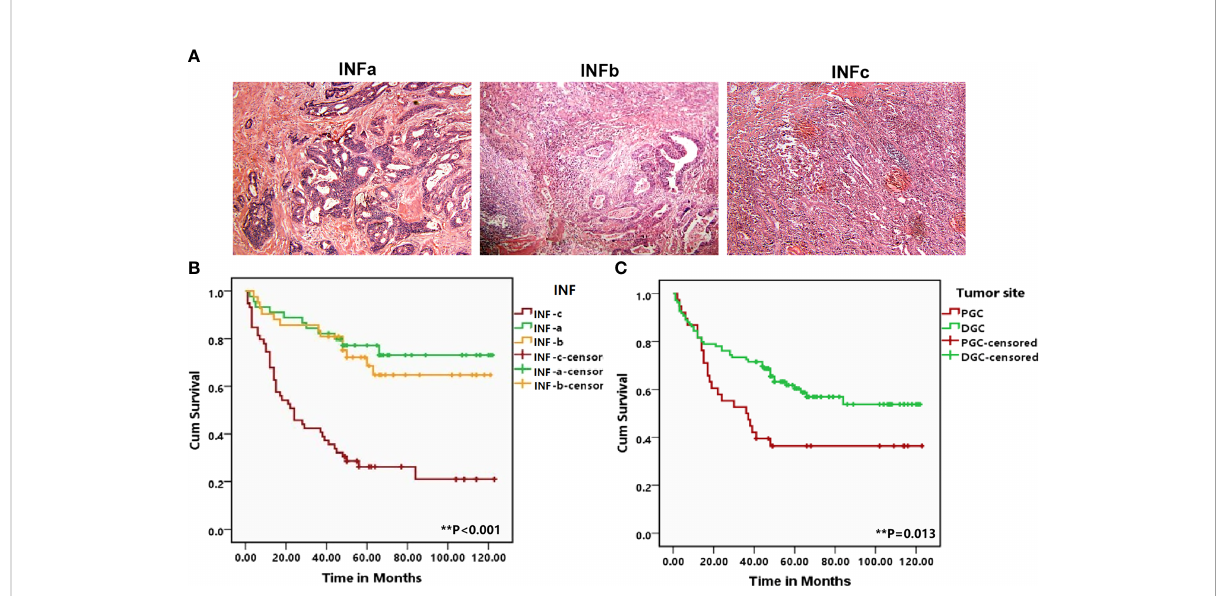
FIGURE 1 (A) Representative patterns of the three types of tumor in fi ltrating growth (INF) pattern of INFa, INFb, and INFc (×100) in the H&E staining slides. (B, C) Corresponding Kaplan – Meier survival curves for proximal gastric cancer (PGC) and distal gastric cancer as well as the different types of INF, respectively. The tumor from the PGC ( P = 0.013) and in fi ltrating with INFc ( P < 0.001) suffered a shorter overall survival. The degree of difference is expressed by the asterisk symbols: ** P < 0.001 and * P <